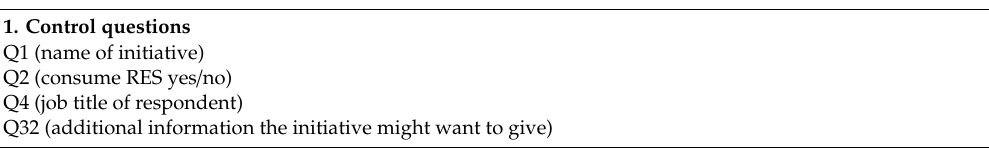
Table A1. Survey questionnaire: distribution of questions according to category. Adapted from: [23] (pp.